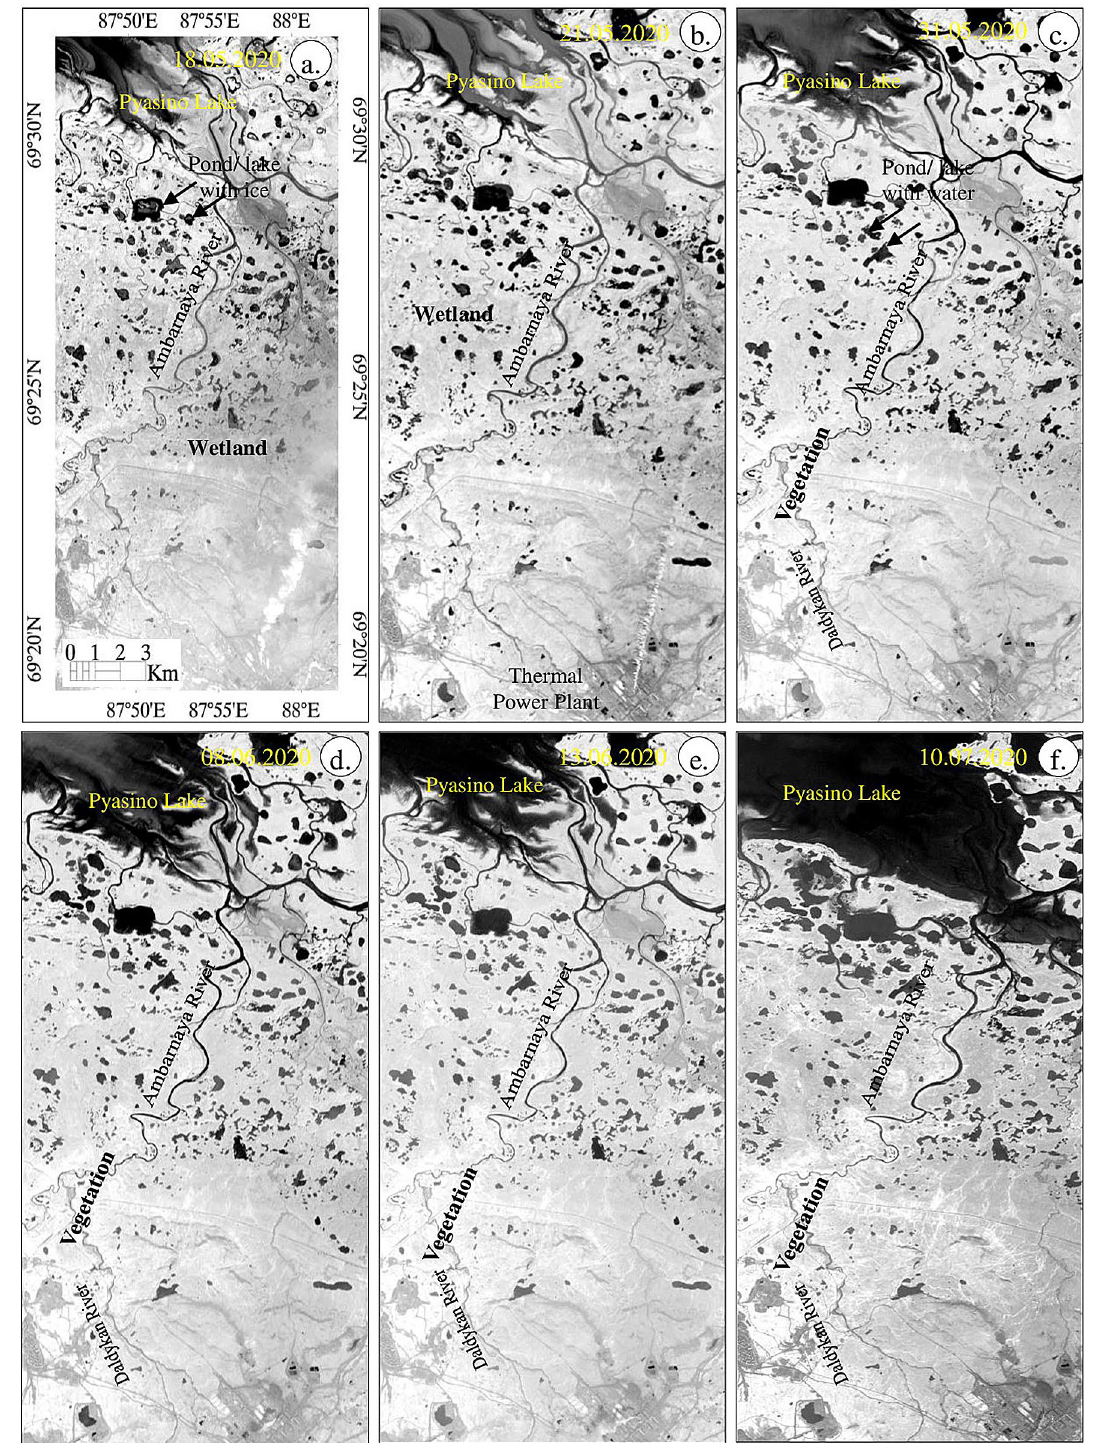
Figure 8. ( a – f ) Sentinel-2 NDVI images of May 18 to July 10, 2020 [ENVI 5.5 https ://www.harri sgeos patia l.com; https ://senti nel.esa.int/] showing the presence of vegetation in bright